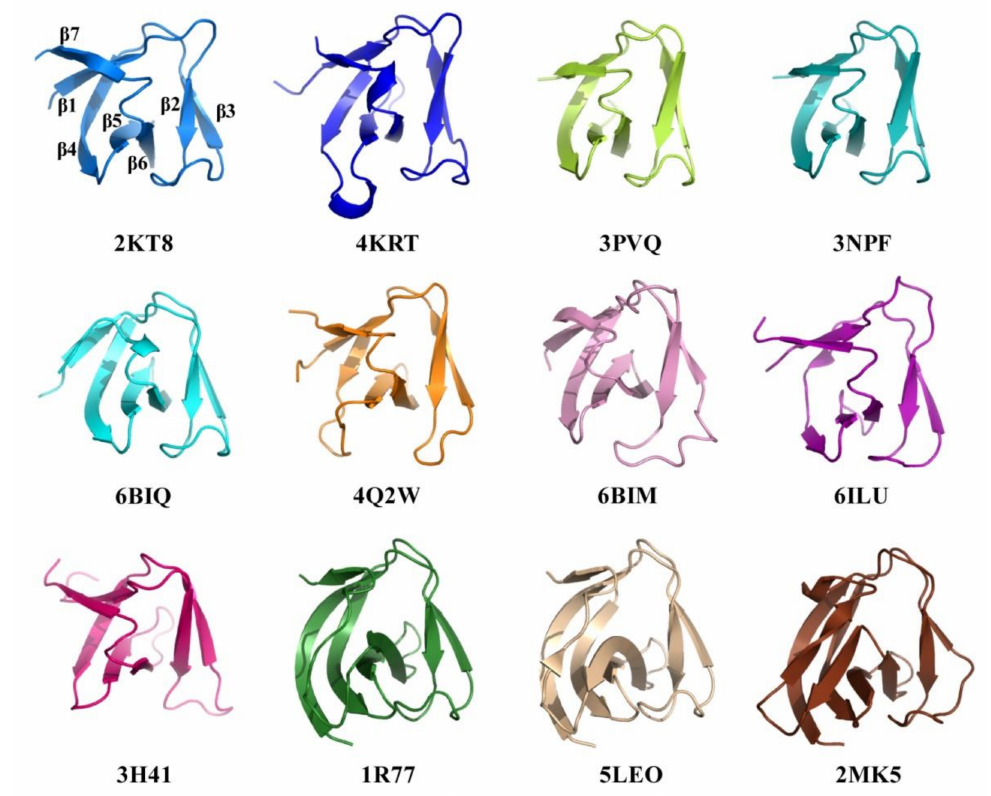
Figure 4. Structure similarity of CpAcp SH3b6 with its SH3b homologues. The structures of CpAcp SH3b6 (2KT8) and its homologues with structural similarity identified using Dali server are shown with cartoon representations in different colors, and the respective PDB IDs of the structures are indicated at bottom. The secondary structure elements of CpAcp SH3b6 are labeled for